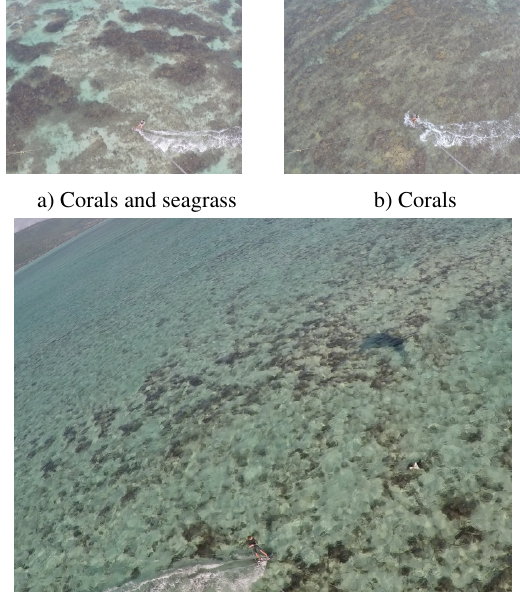
Figure 6. Examples of aerial